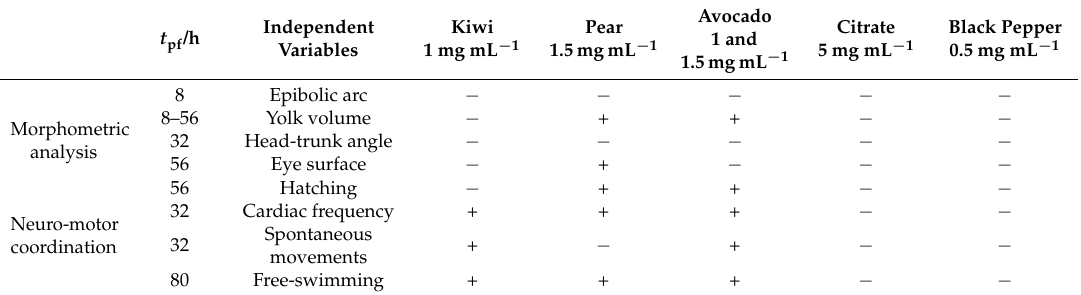
Table 3. Zebrafish embryotoxicity testing. (+) corresponds to a statistically significant effect and ( − ) corresponds to a non-significant effect on tested